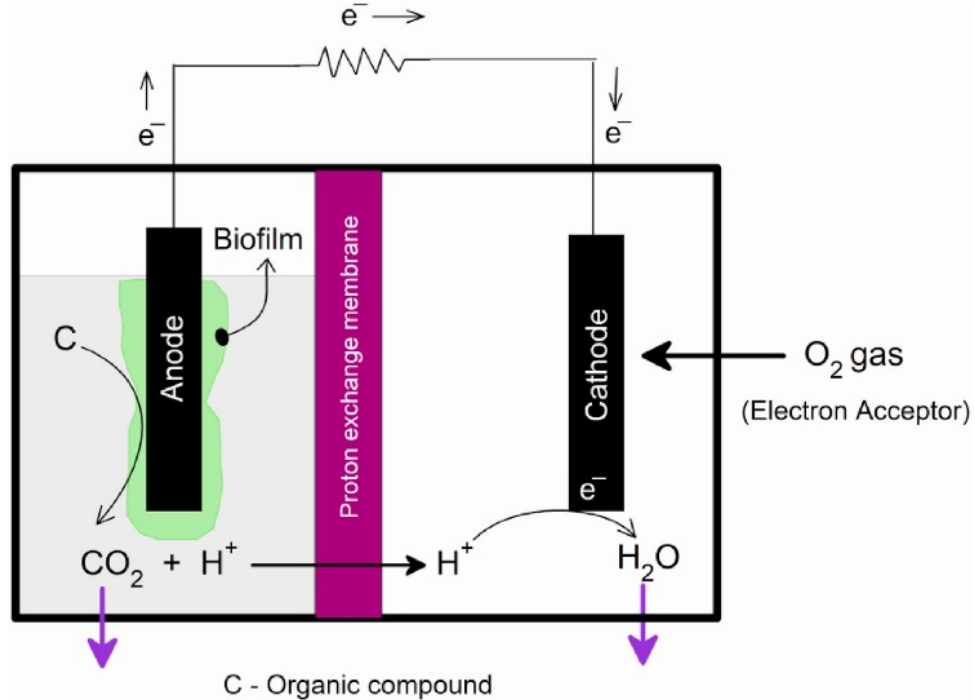
Figure 2. A typical MFC system (reprinted with permission of Elsevier) [91].